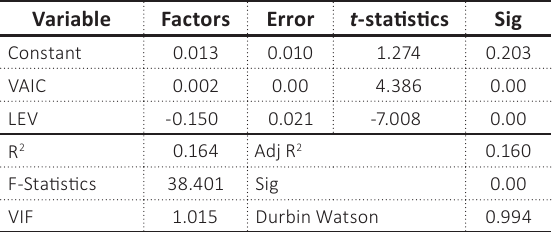
Table 6. The first model (Small companies)